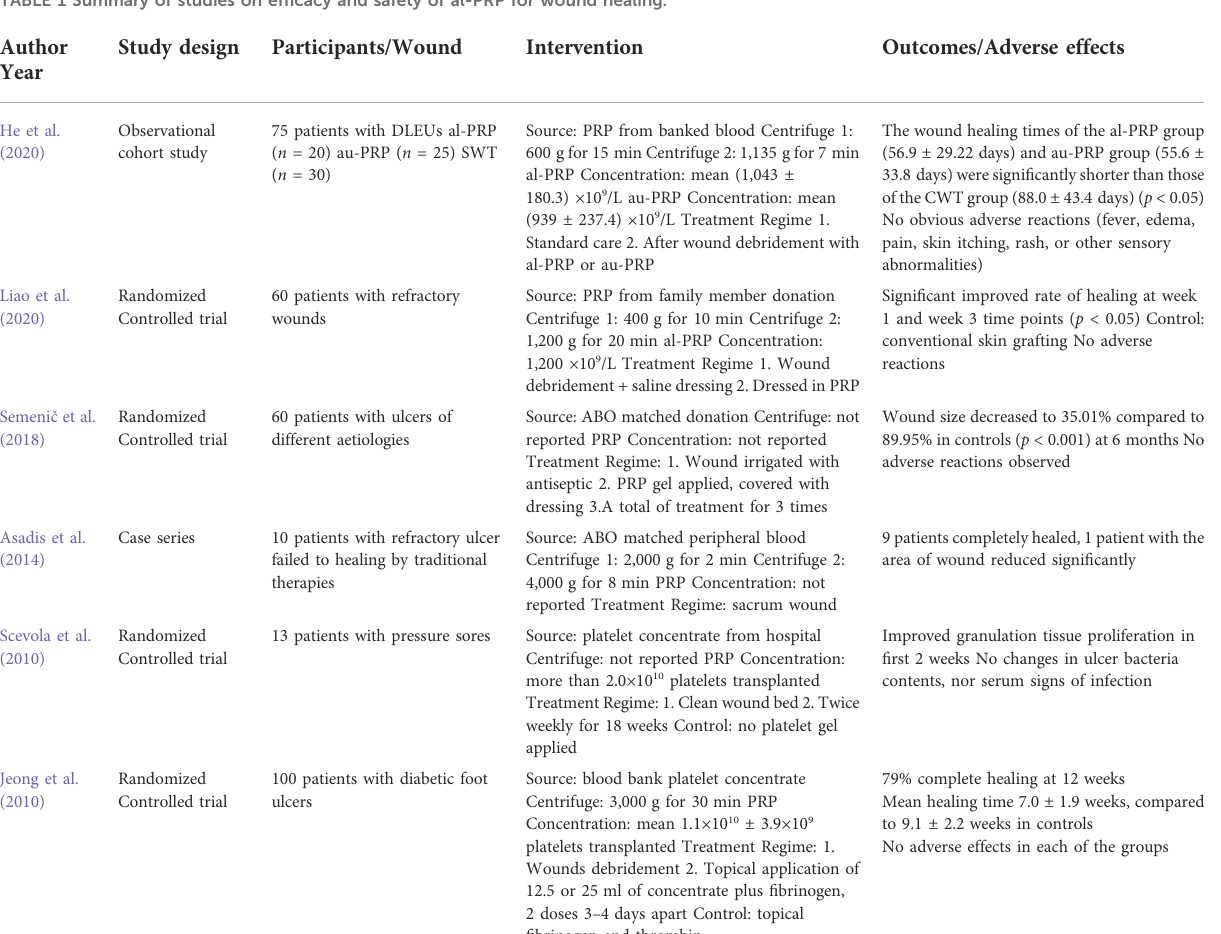
TABLE 1 Summary of studies on ef fi cacy and safety of al-PRP for wound